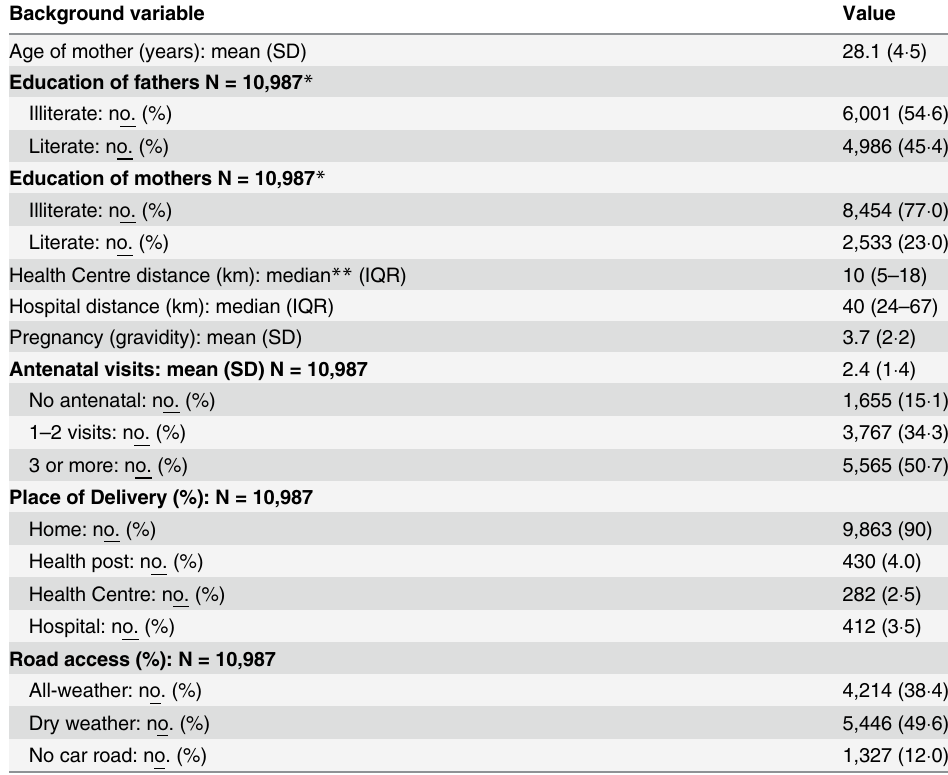
Table 1. Socio-demographic data on parents, services, and infrastructures in the birth registry dis- tricts of south Ethiopia in 2010. Background